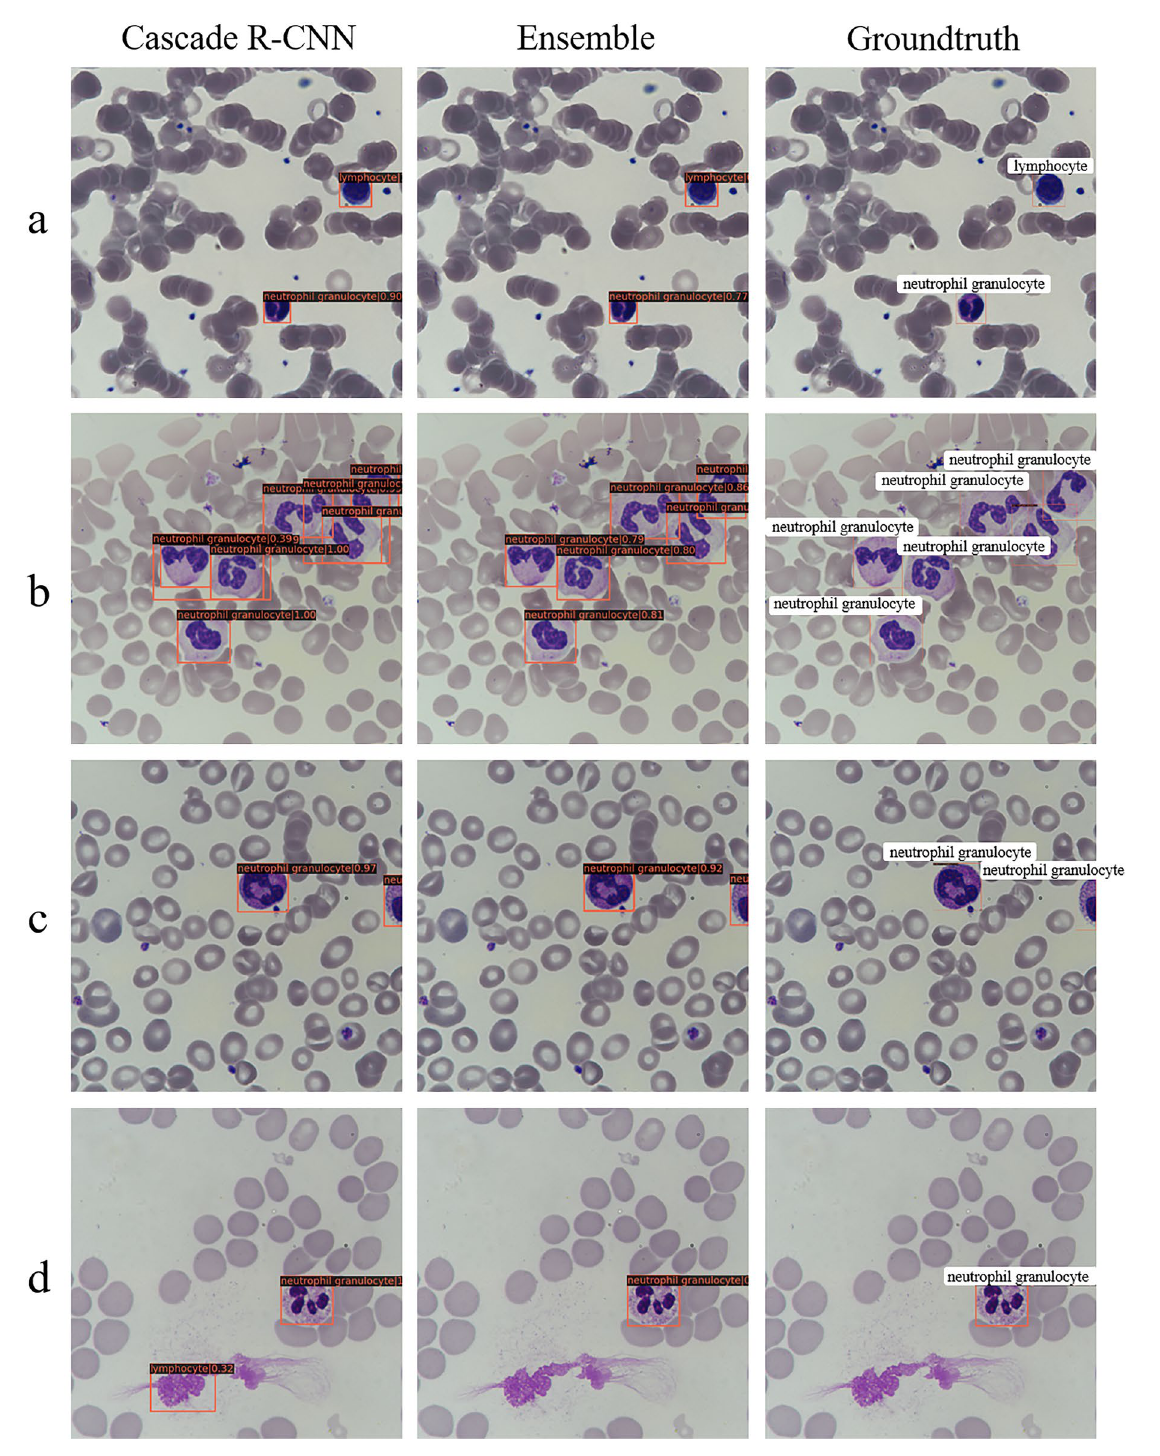
Figure 5. Some real examples of detecting leukocytes in different scenarios with Cascade R-CNN and the ensemble model. ( a ) An example of excessively high phosphate buffer solution (pH > 6.8) and small neutrophils. ( b ) An example of overlapping leukocytes. ( c ) An example of incomplete leukocytes. ( d ) An example of impurities in the